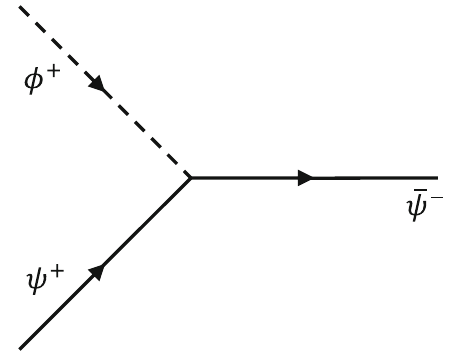
Fig. 1 The Feynman diagram for the neutral atom-ALP interaction